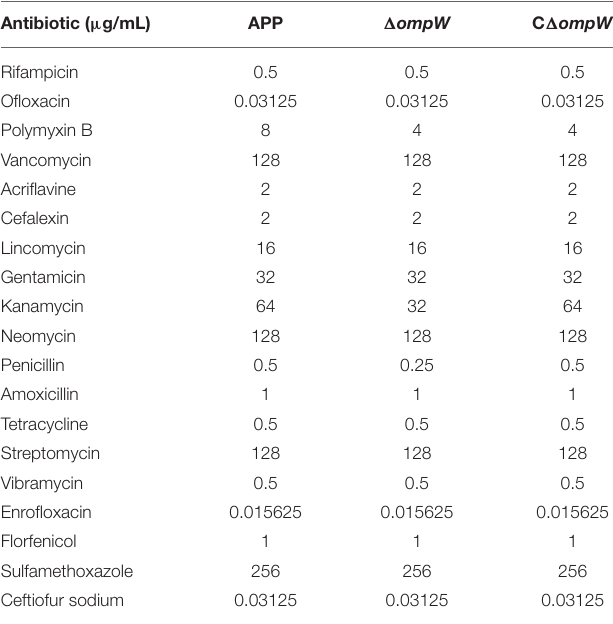
TABLE 3 | Determination of MICs for the three bacterial